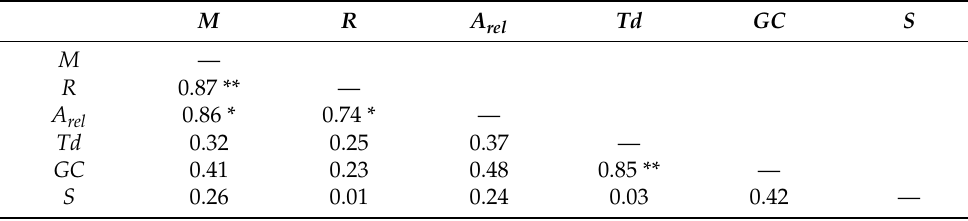
Table 6. Matrix of Spearman’s correlation coefficient (cid:36) between the species mixing index ( M ), aggregation index ( R ), relative species profile index ( A rel ), diameter differentiation index ( Td ), Gini coefficient ( GC ), and hyperbolic tangent index ( S